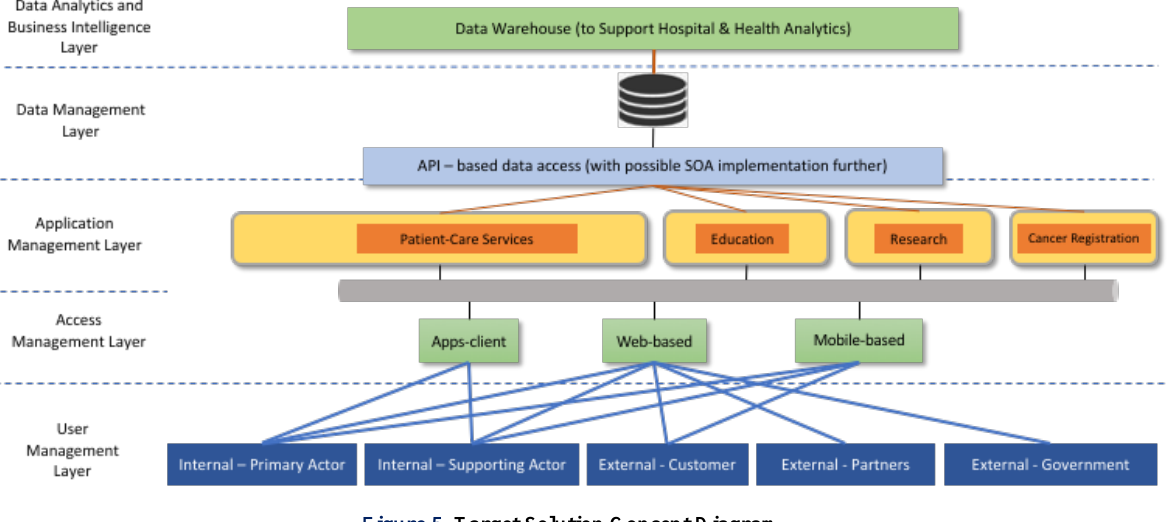
Figure 5. Target Solution Concept Diagram.